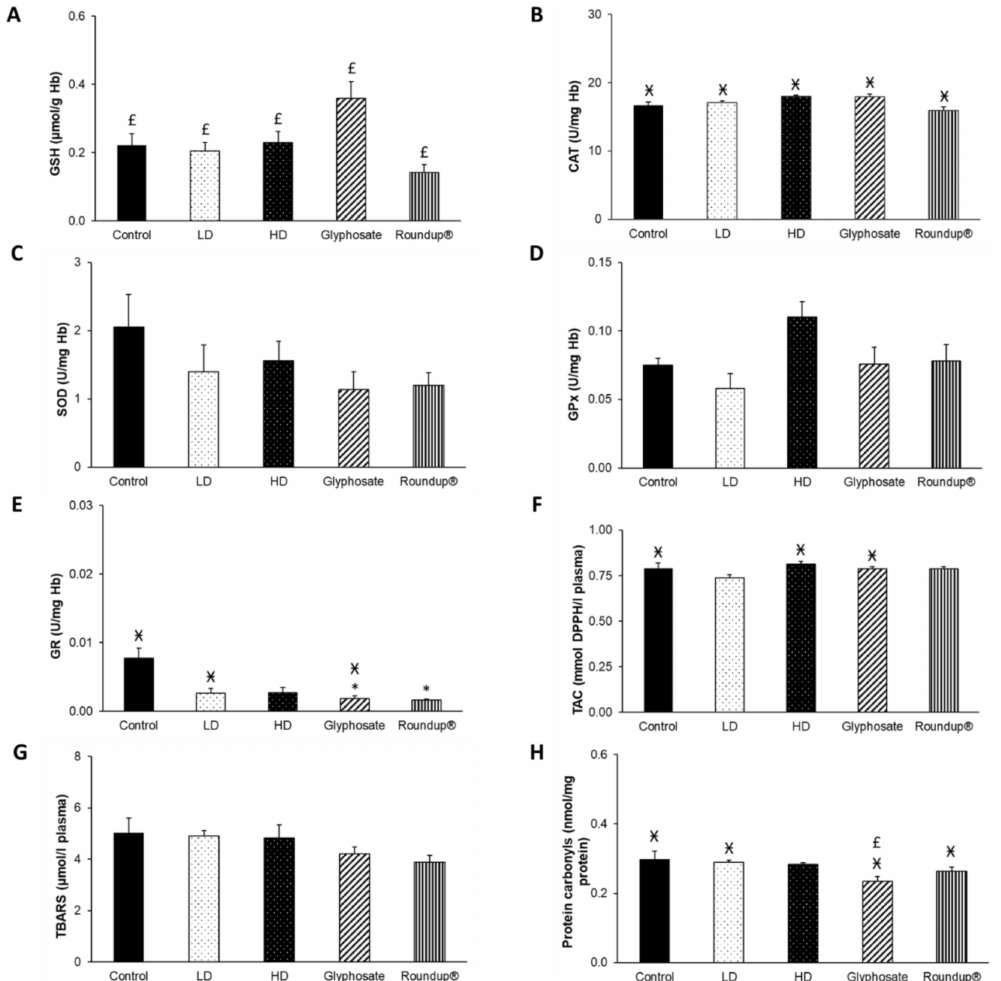
Figure 4. The effects of 9-month exposure of New Zealand rabbits to the EDs mixture, glyphosate, and Roundup ® on blood GSH concentration ( A ), CAT activity ( B ), SOD activity ( C ), GPx activity ( D ), GR activity ( E ), TAC levels ( F ), TBARS levels ( G ), and protein carbonyls concentration ( H ). *: Statistically Ӿ : Statistically significant difference within significant difference compared to the control group. the same group compared to 3 months. £: Statistically significant difference within the same group compared to 6